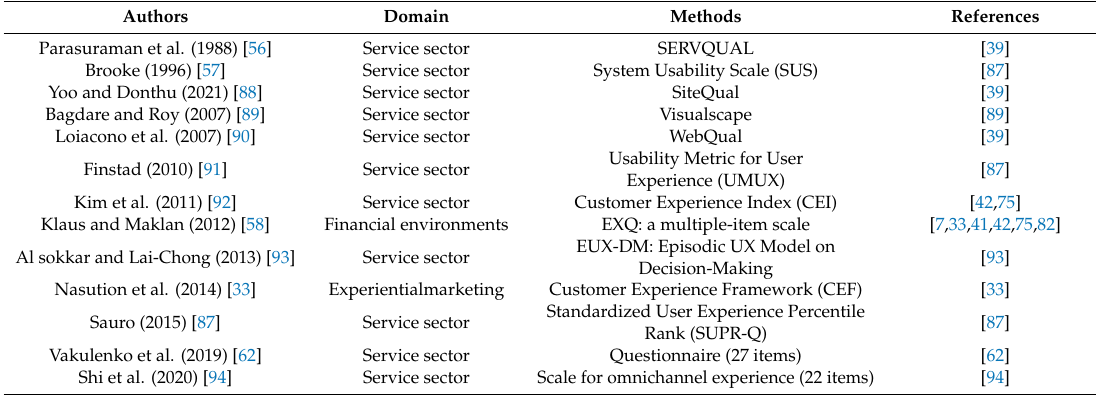
Table A3. Evaluation methods of customer